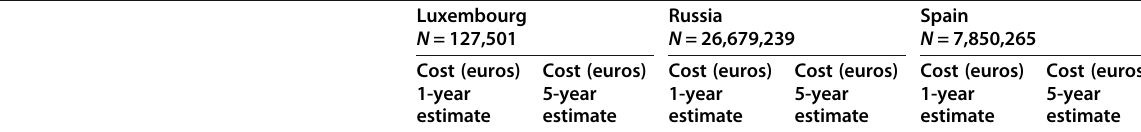
Table 7 TTH costs (population